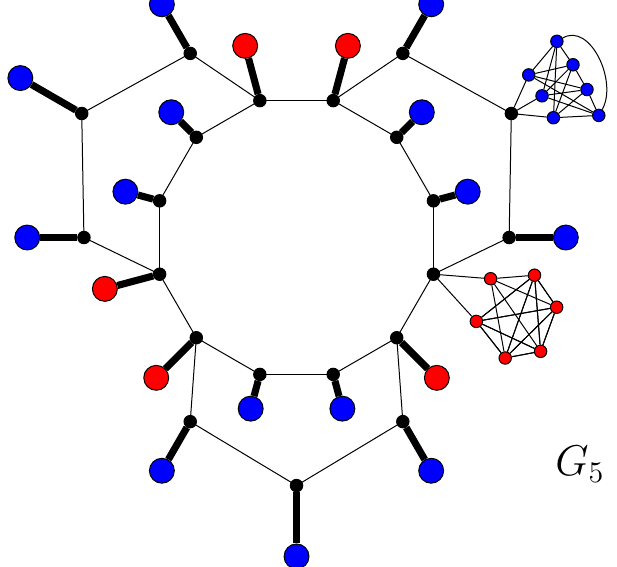
Figure 3: The graph G is a 5-regular, 2-edge-connected graph with proper connection 5 number greater than 2. To simplify the drawing, all large red nodes represent K all large blue nodes represent C + 3 K . Thick edges between vertices of M and large nodes 4 1 (red or blue) are used to indicated the 2 (or 3) edges between the vertex of M and the K (or C + 3 K 4 1